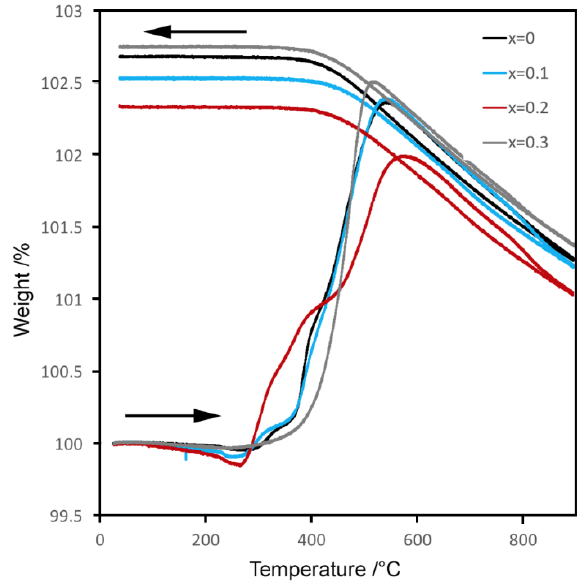
Figure 6. Weight change of N 2 -annealed Sr 3 − x Pr x (Fe 1.25 Ni 0.75 )O 7 − δ upon heating (starts at 100%) and then cooling in air.